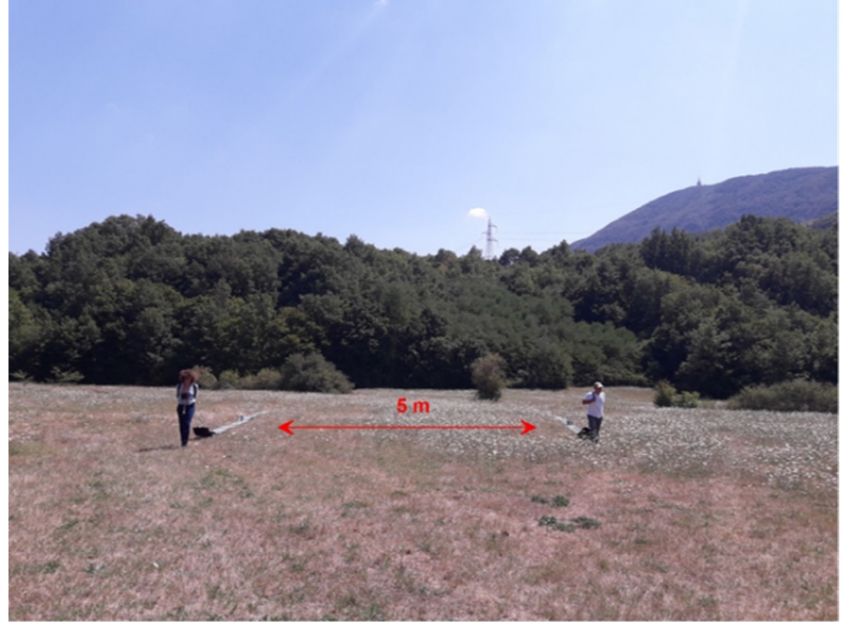
Figure 7. Parallel array of the low-frequency GPR survey at the “Il Lago” Plain; photo taken from the NE towards the SW looking Mt. Patalecchia.